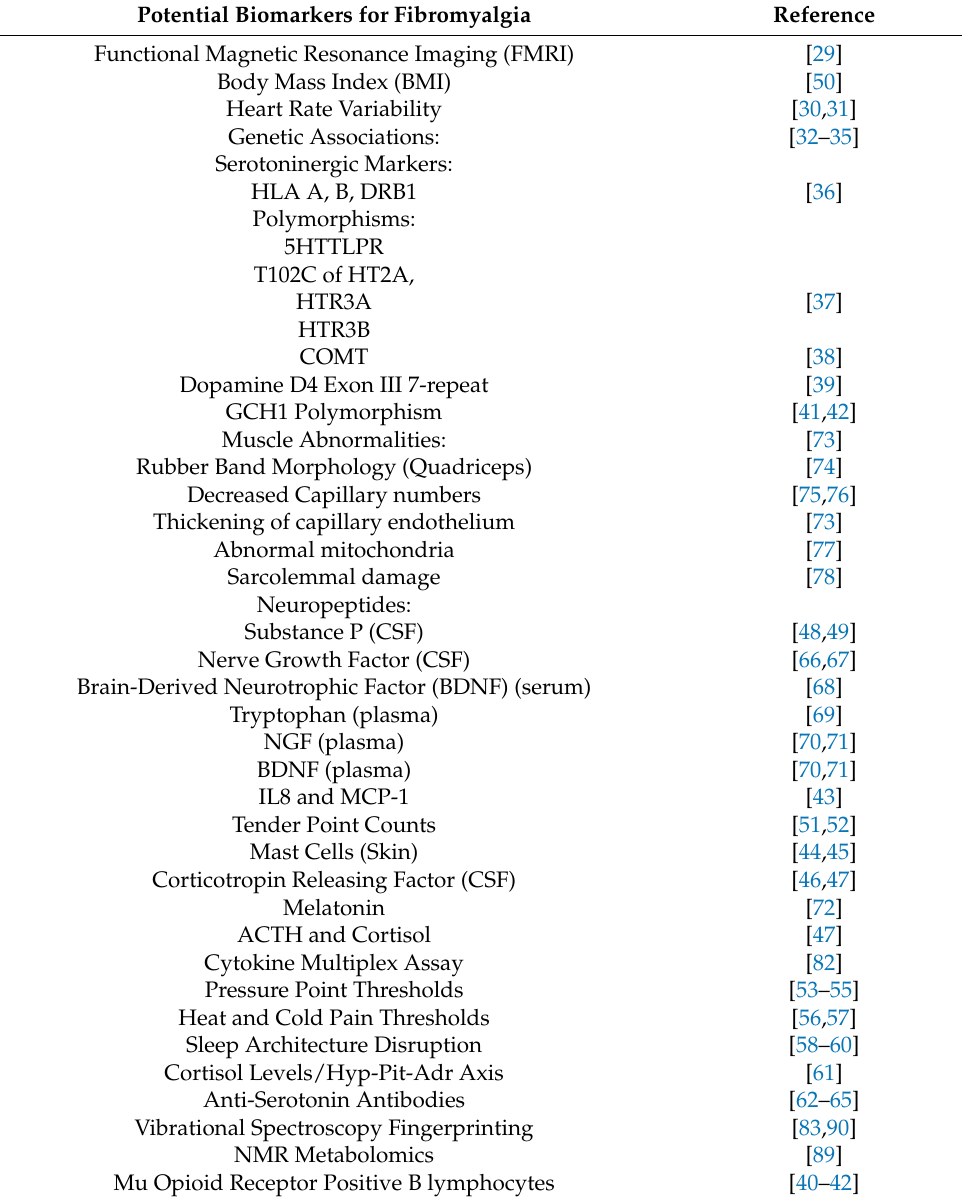
Table 1. Listing of putative biomarkers and corresponding